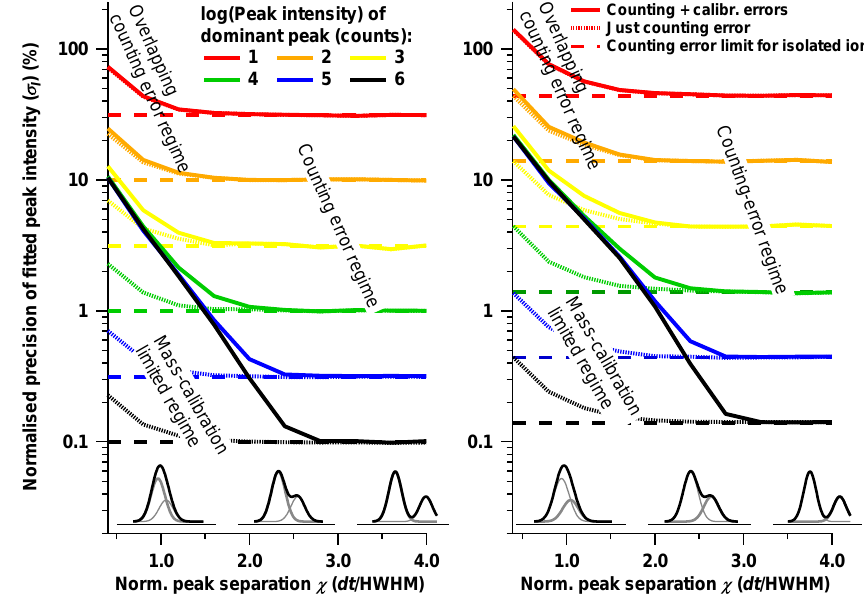
Figure 4. Precision on fitted peak intensity, σ I , as a function of peak separation for an overlapping ion pair. Colours: peak intensity of the dominant ion (left); the weaker ion (right) is half as intense. The dominant peak is centred at 2000ns; both have a width of 1ns, and the data-point spacing is